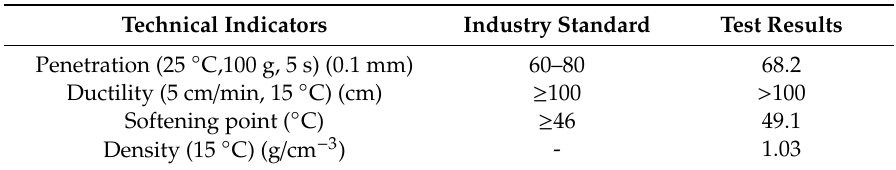
Table 1. Technical properties of 70# neat